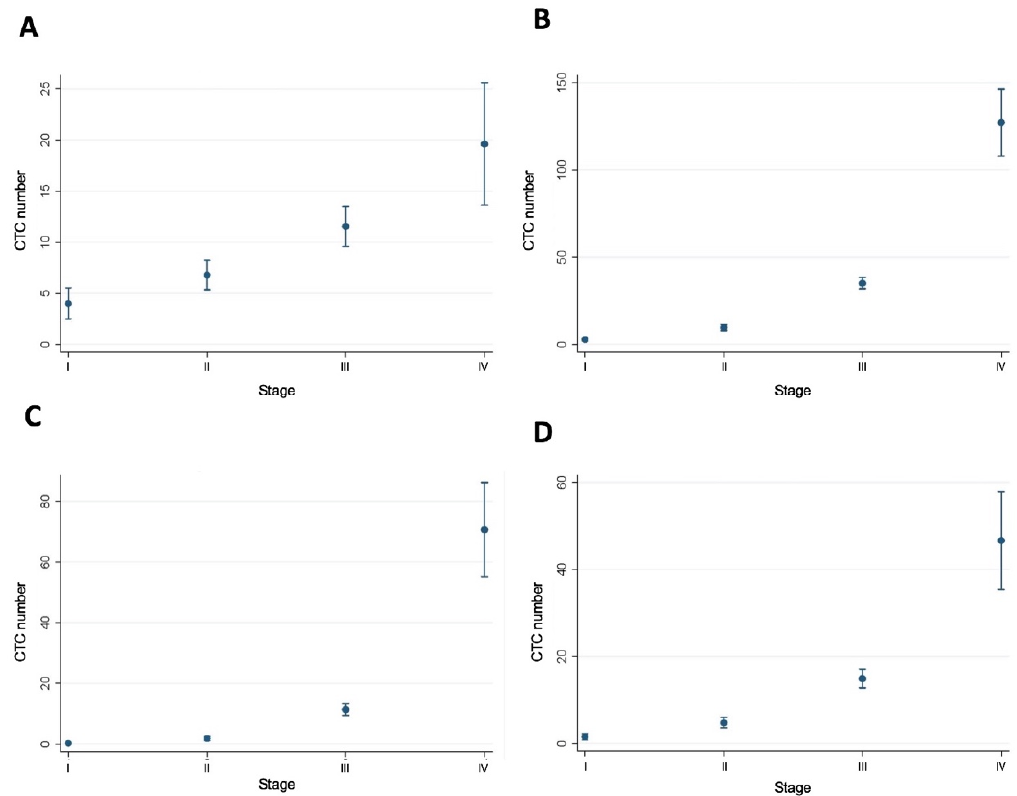
Figure 4. Poisson regression model with post-estimation marginal fundamental analysis of stage and CTC number at sample time points t1 and t2 (Panels A and B ) and t3 and t4 (Panels C and D ).